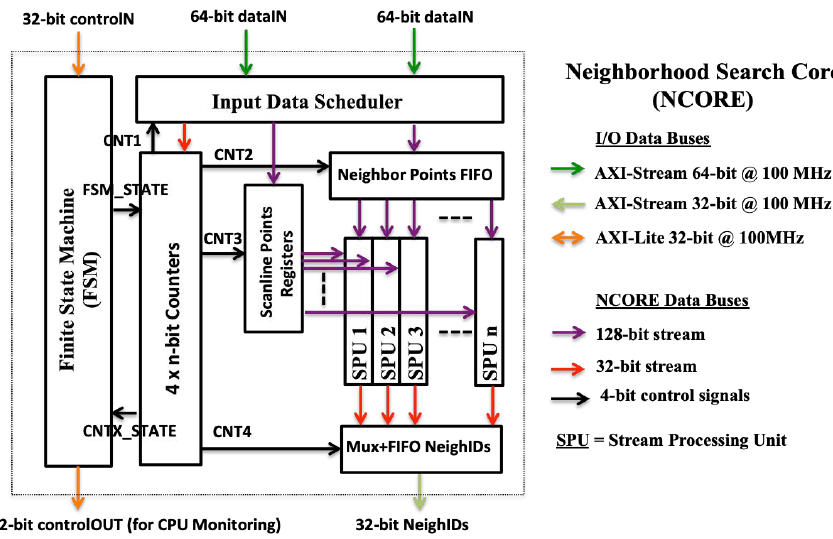
Figure 16. Neighborhood processing unit (Neighbourhood Search Core (NCORE)) architecture.